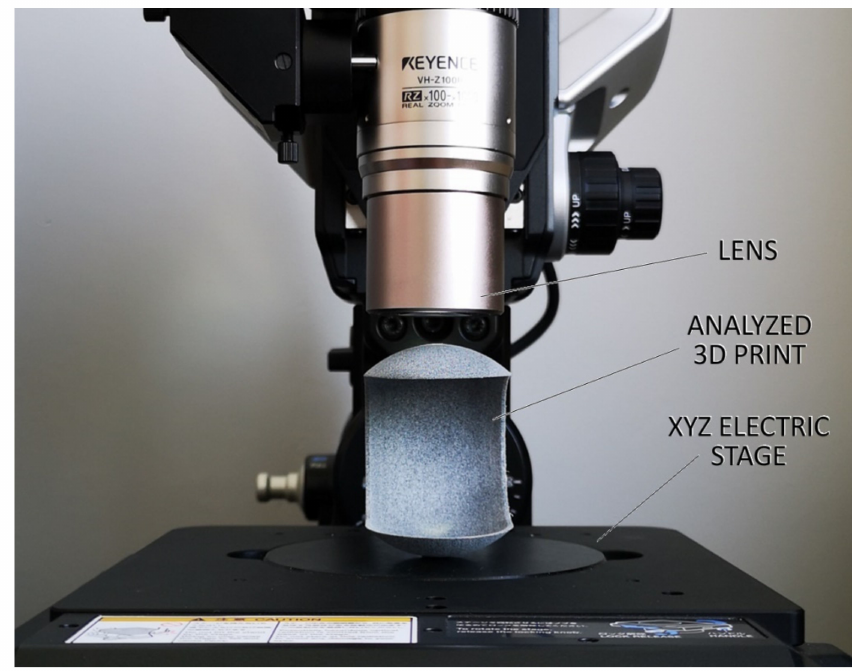
Figure 4. The setting of analyzed prints on the microscope for investigations.